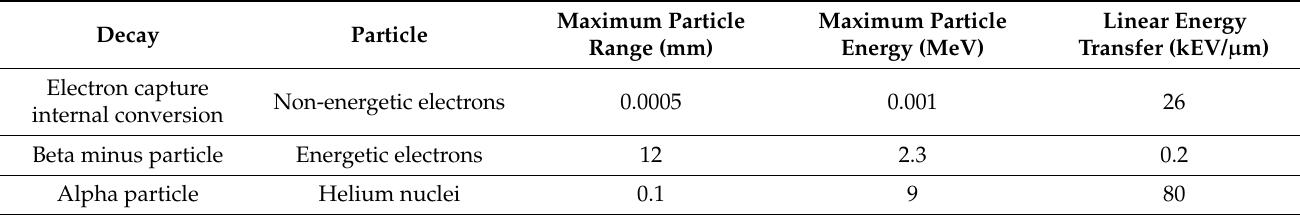
Table 1. General characteristics of therapeutic